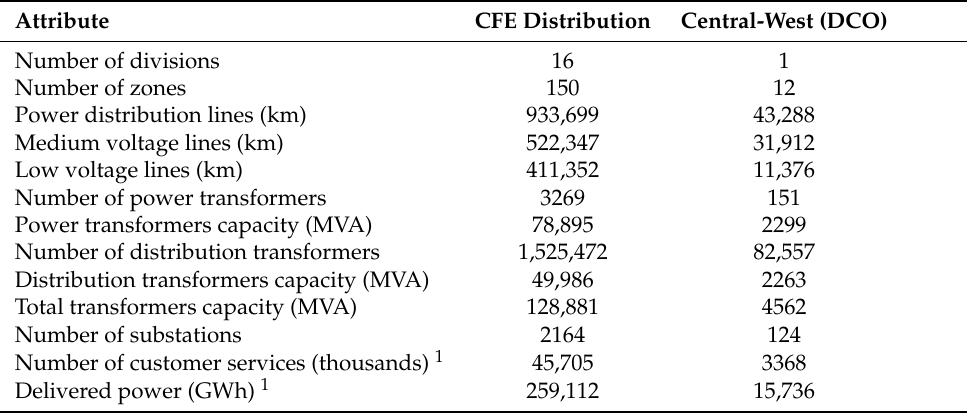
Figure 1. CFE manages Mexico’s electric power distribution on the basis of 150 geographical zones grouped into 16 divisional units. CFE’s Central-West Division (DCO) is in charge of 12 zones (yellow) located in the Mexican states of Michoacan and Colima. The combined land area of these two states is over 64,200 square kilometers. Table 2. Power distribution grid research context (values to